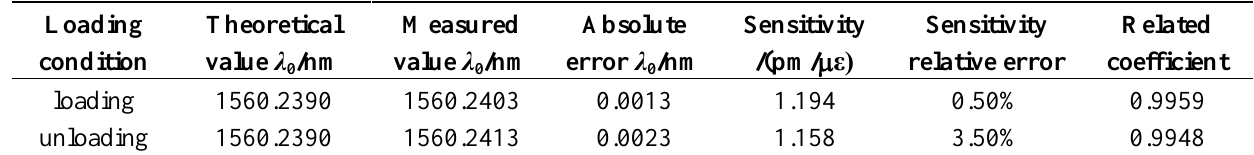
Table 1. Sensitivity and initial wavelength error analysis of FBGs